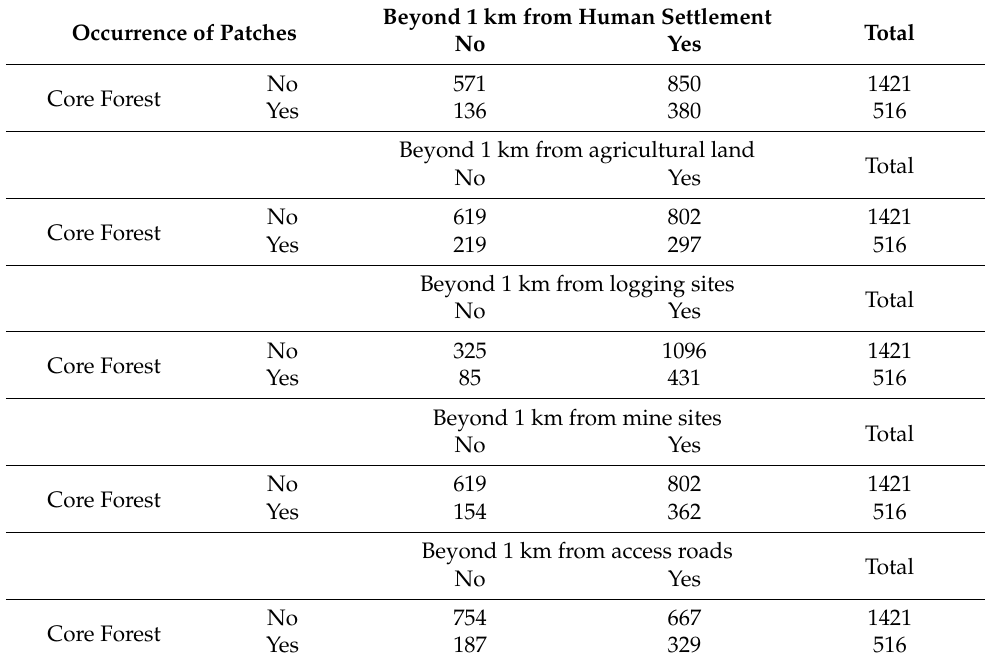
Table A4. Patches of forest cover and the distance-land use